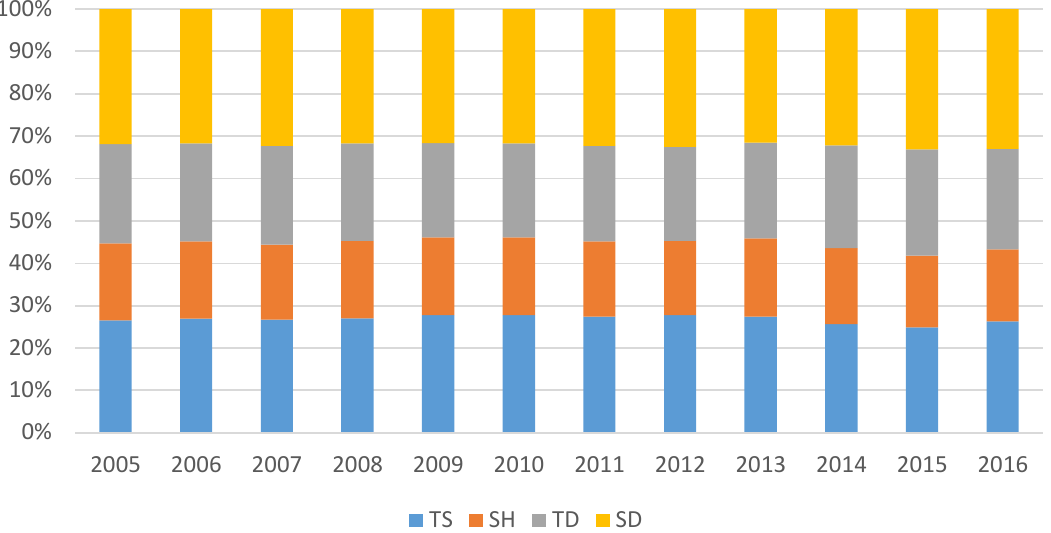
Figure 3. Correlation of the levels of the properties expressiveness, which ensure the sustainability of enterprises (generalized by groups of enterprises)